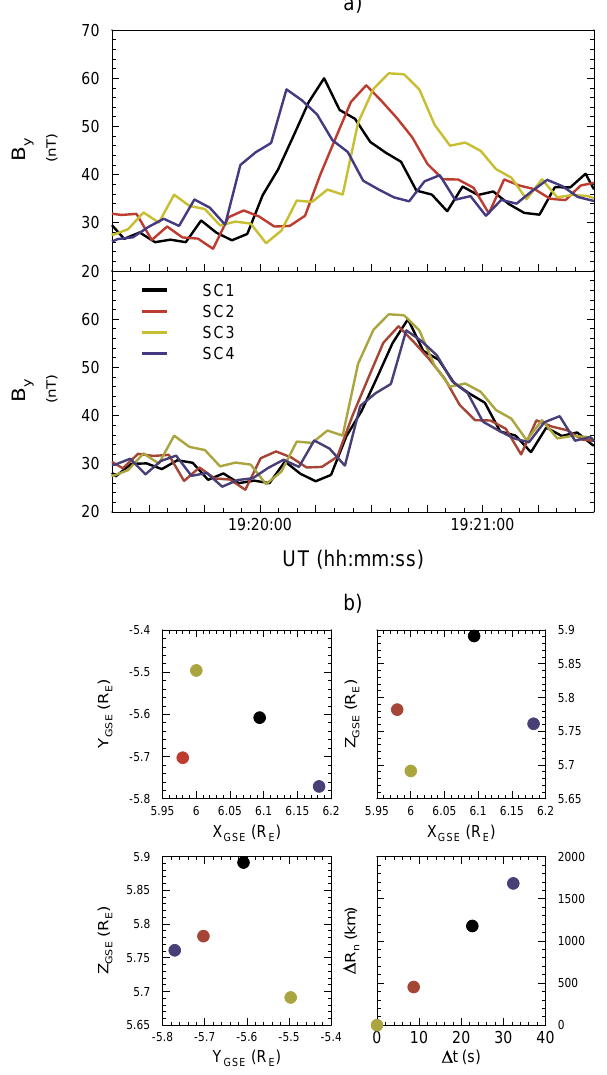
Fig. 5. (a) Upper panel: the GSE B y component of the magnetic field of the third discontinuity as seen by the four Cluster space- craft. Bottom panel: same as in the upper panel but with the SC1, SC2 and SC4 profiles of B y suitably shifted ahead in time (only the SC3 profile is unchanged). (b) First three panels: Cluster spacecraft GSE positions at the time of the third discontinuity passage. Last panel: the spacecraft dis- tances from SC3, calculated along the n III direction (see Table 1), plotted versus the time delays expected under the hypothesis that the third discontinuity is moving along n III with the local plasma = − 52km/s (Table 1 and Fig. 4). The amounts of speed of U n ( III ) these delays equal the time shifts applied to the B y profiles in the bottom panel of